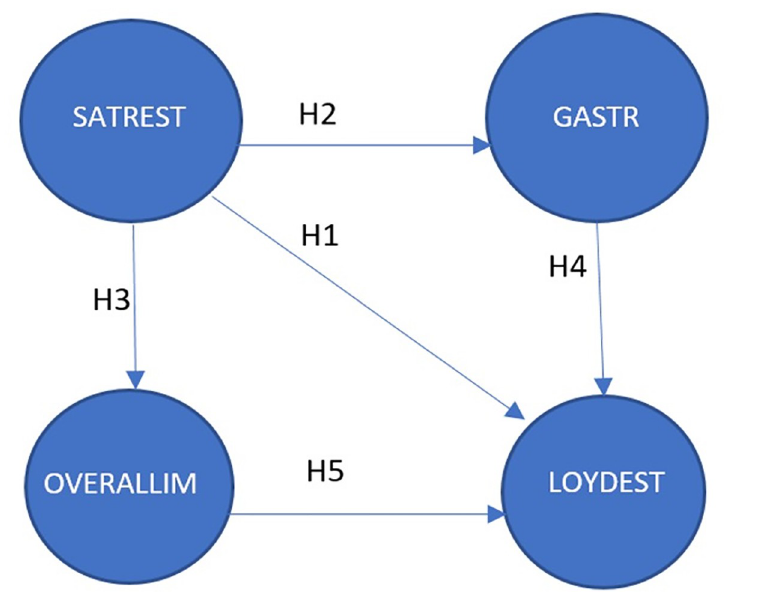
Fig 1. Proposed research design. Source: